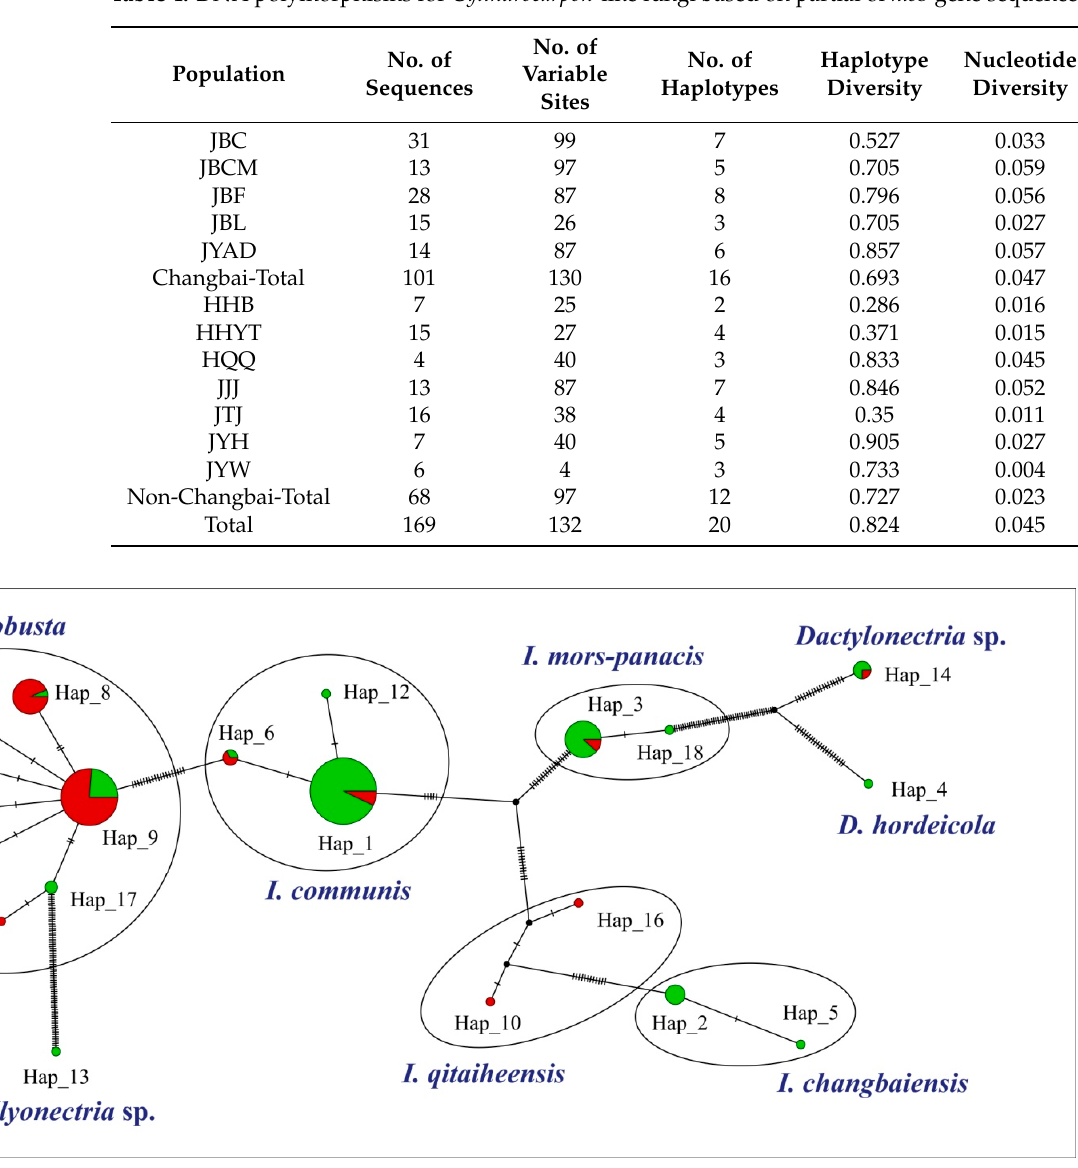
Table 4. DNA polymorphisms for Cylindrocarpon -like fungi based on partial of his3 gene sequences.